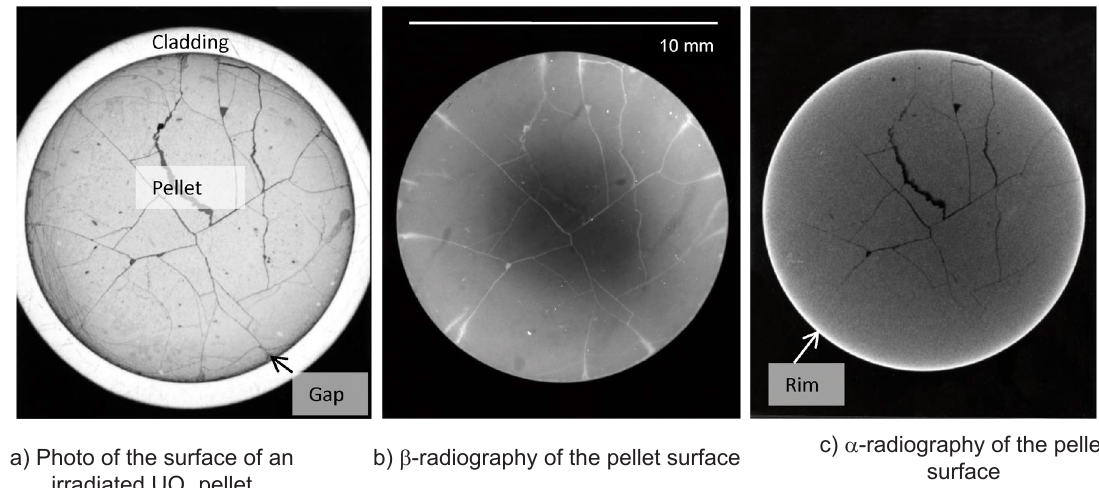
pellet, the gap between pellet and cladding, 2